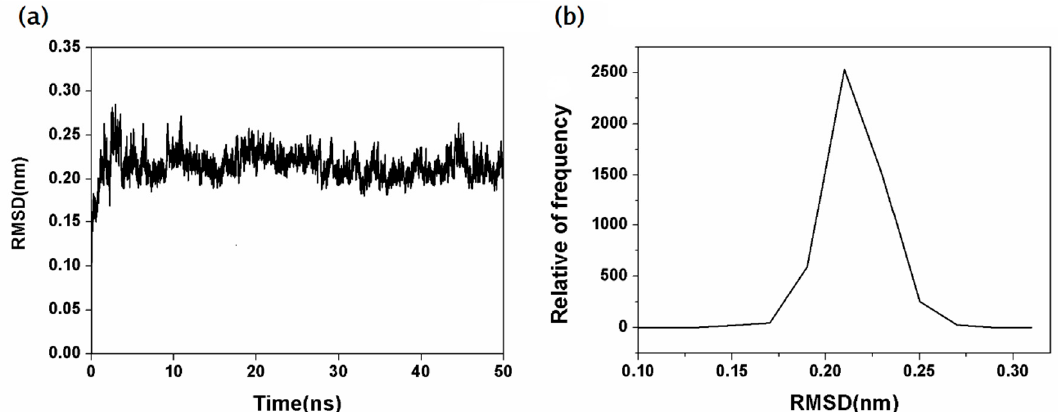
Figure 2. ( a ) Root-mean-square deviation (RMSD) plot of the NanA–chlorogenic acid complex during molecular dynamics simulation. ( b ) Average RMSD values for the system during the 50 ns molecular dynamics simulation.